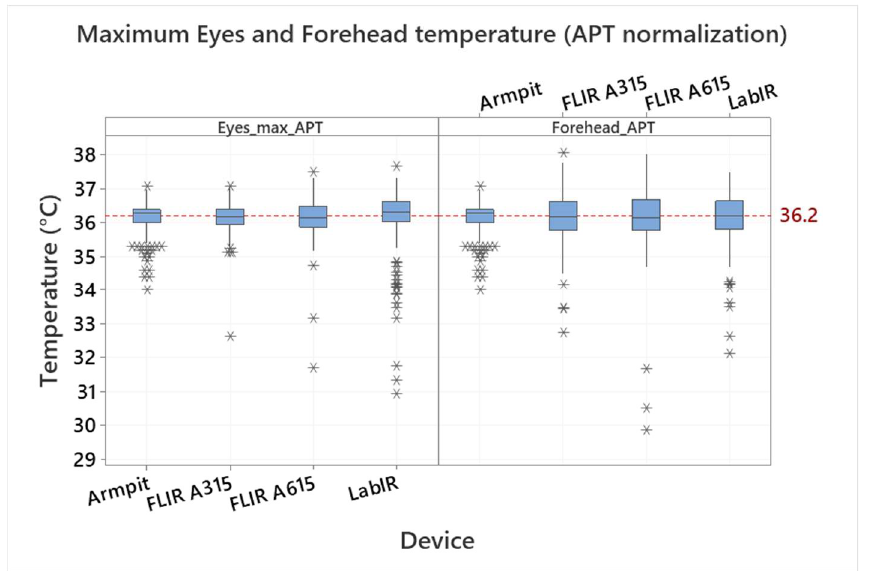
Figure 5. Comparison of eyes maximum (inner canthus) and forehead temperature measured by the FLIR A315, FLIR A615 and LabIR cameras (blackbody correction and armpit temperature normali- zation applied) with the body temperature measured by the armpit thermometer. Outliers are iden- tified by asterisks (*).